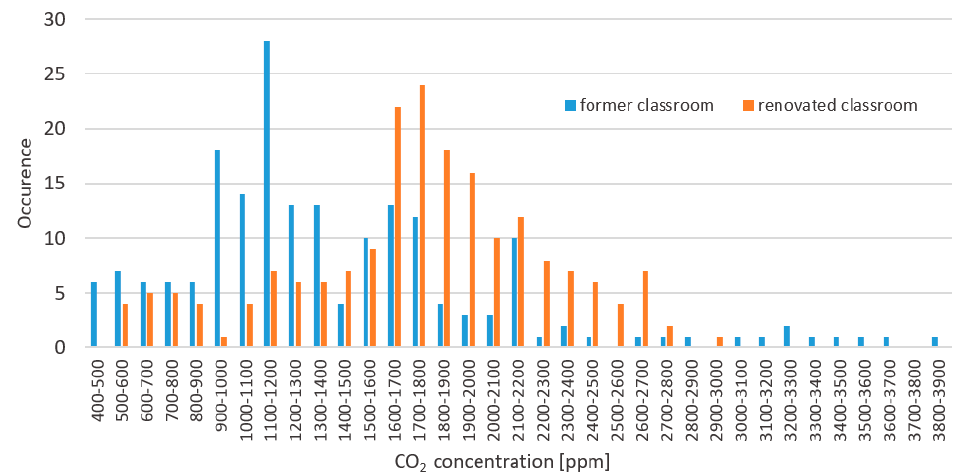
Figure 10. Histogram of mean values of measured CO 2 concentration.